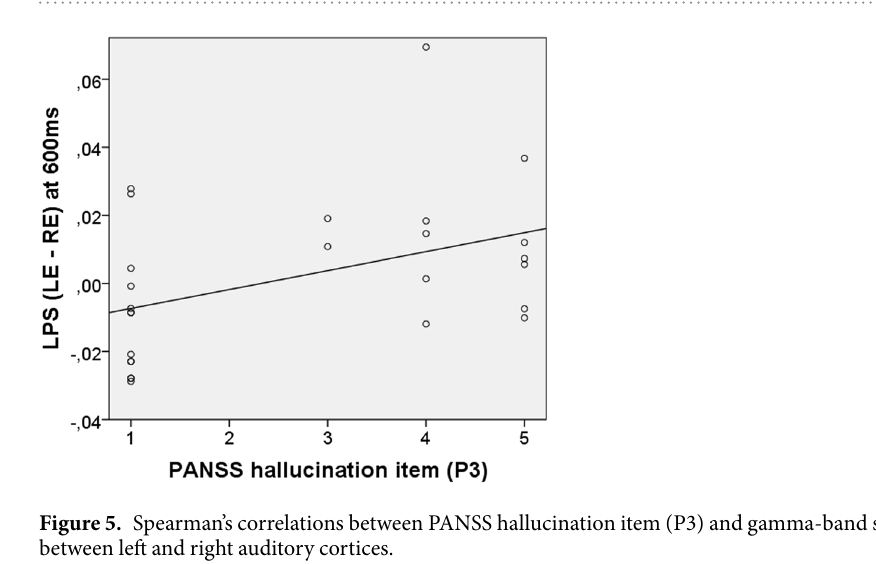
Figure 4. ( A ) Time course of interhemispheric connectivity difference between left ear (LE) and right ear (RE) reports in the gamma-band (30–100 Hz) between bilateral auditory cortices (BA41 and BA42) for AVH, non- AVH and HC participants. Syllable presentation starts at 0 ms and ends around 500 ms. The quality of gamma- band connectivity was found to be significant differently over time across the three groups. ( B ) Time course of interhemispheric gamma-band connectivity during conscious perception of LE or RE syllables between bilateral auditory cortices of hallucinating patients (AVH). Shaded error bars: + / − 1 standard error. HC, healthy controls; AVH, hallucinating patients; non-AVH, non-hallucinating patients; LE, left ear; RE, right ear.